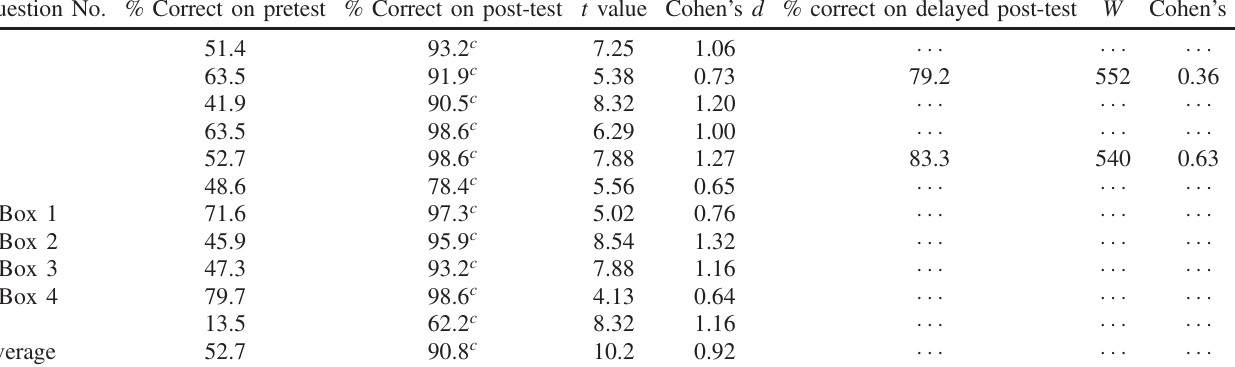
TABLE II. Pretest, post-test, and delayed post-test results for the QKD QuILT broken down by question. The pretest and post-test results and corresponding t tests and effect sizes using Cohen ’ s d are based on 74 students ’ paired responses with an average score of 52.7% (pretest) and 90.8% (post-test), respectively. The delayed post-test results are based on answers from 24 students (with the associated Wilcoxon ranked-sum test and Cohen ’ s d calculations performed with matched post-test and delayed post-test data). The two questions that make up the delayed post-test were selected as particularly good examples of questions that require an understanding of QKD and quantum mechanics principles related to the QKD protocol to answer. For each question involved in this table, the superscript “ a ” means p < 0 . 05 , “ b ” means p < 0 . 01 , and “ c ” means p < 0 . 001 for the t test or Wilcoxon ranked-sum test conducted with the null hypothesis that there is no statistically significant difference between the means of pretest and post-test or post-test and delayed post-test, respectively. For pretest and post-test comparisons using t test, t values are reported with the critical t value for p < 0 . 05 being 1.99 and for post-test and delayed post-test comparisons using the Wilcoxon ranked-sum test, W is reported with the critical value of W for p < 0 . 05 being